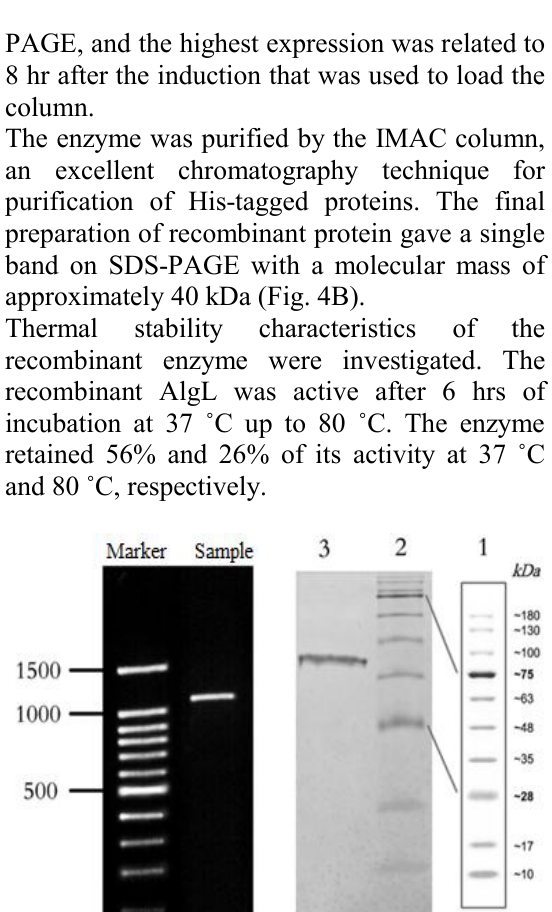
Fig. 3. Effect of pH on the activity and stability of alginate lyase (AlgL) from P. aeruginosa strain 293.